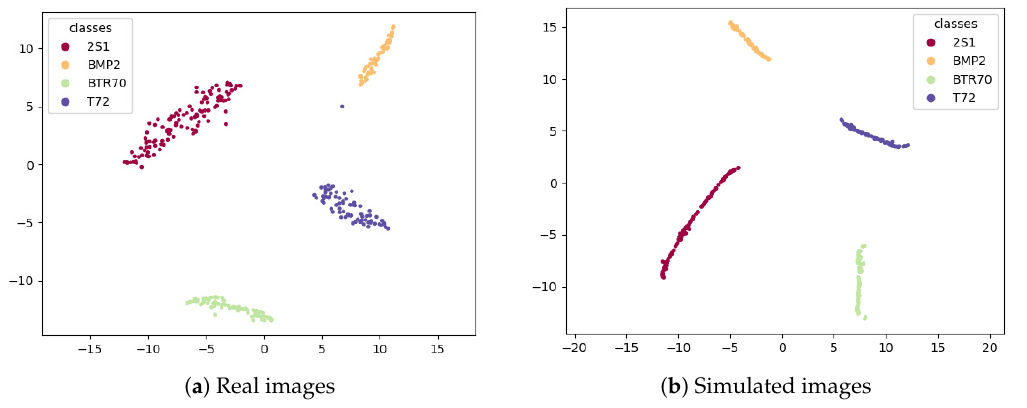
Figure 19. ( a ) The two-dimensional t-SNE representation of features in real images. ( b ) The two- dimensional t-SNE representation of features in simulated images.